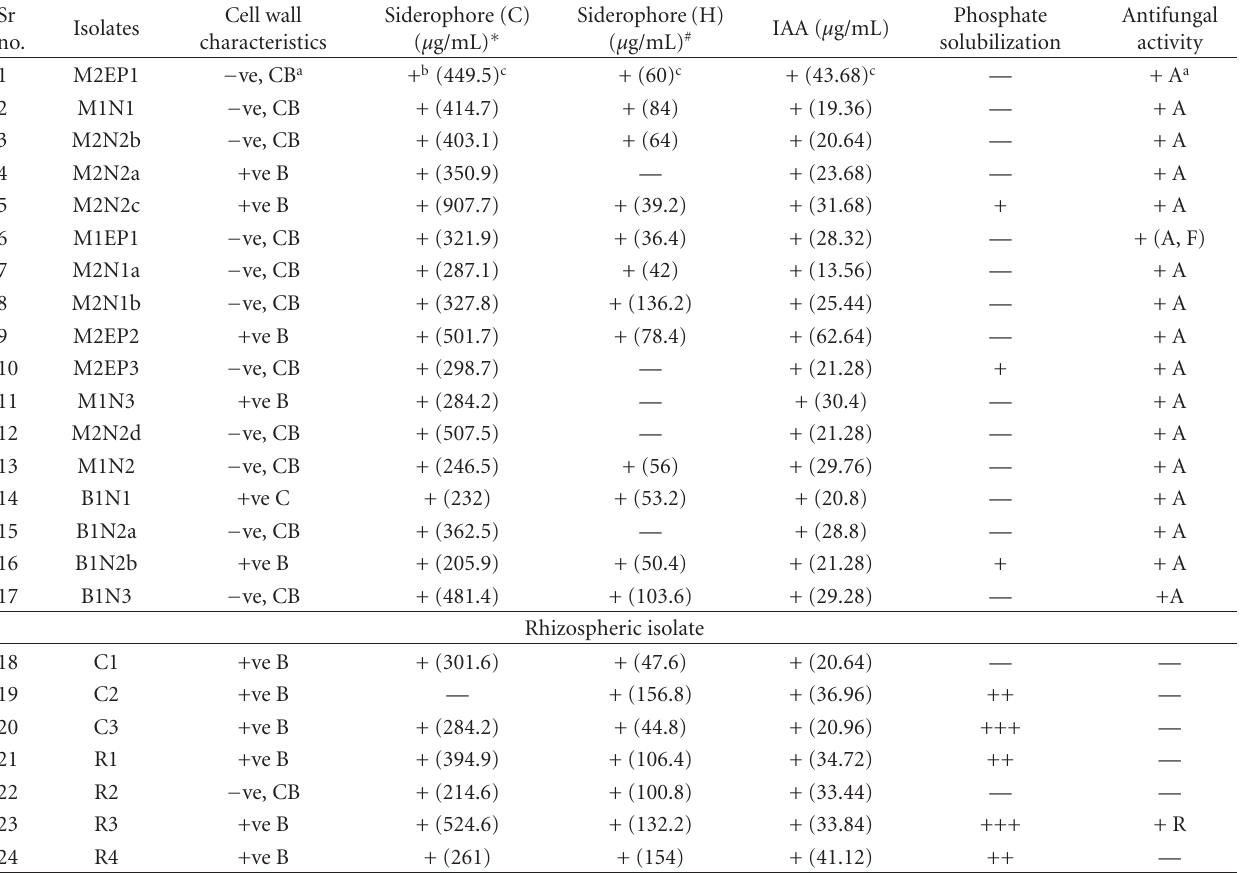
Table 1: Plant growth-promoting characteristics of the Fenugreek NAB and Rhizospheric isolates. Sr